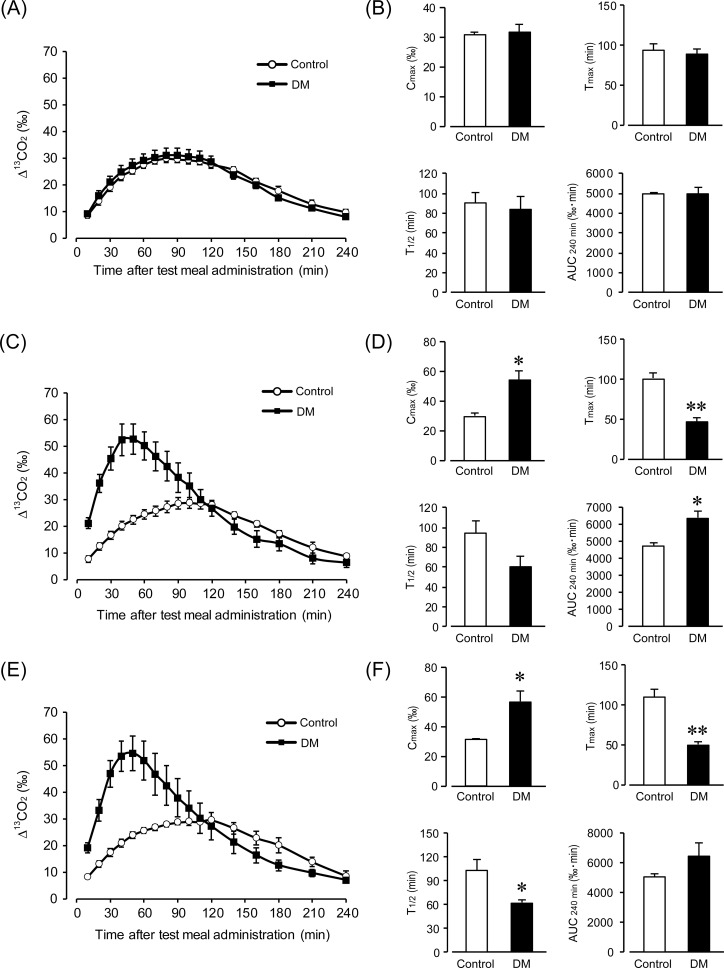
Accelerated gastric emptying in the early stage of type 1 diabetes.(A) and (B) Time-course of gastric emptying at 0 week following an injection of streptozotocin (STZ) in control and diabetic (DM) mice. Quantification of Cmax, Tmax, AUC240min, and T1/2 are calculated from (A). Each column shows the mean ± SEM (n = 5). (C) and (D) Time-course of gastric emptying, Cmax, Tmax, AUC240min, and T1/2 at 2 weeks following an injection of STZ in control and DM mice. Each column shows the mean ± SEM (n = 5). *P < 0.05, **P < 0.01; significantly different from control. (E) and (F) Time-course of gastric emptying, Cmax, Tmax, AUC240min, and T1/2 at 4 weeks following an injection of STZ in control and DM mice. Each column shows the mean ± SEM (n = 5). *P < 0.05, **P < 0.01; significantly different from control.